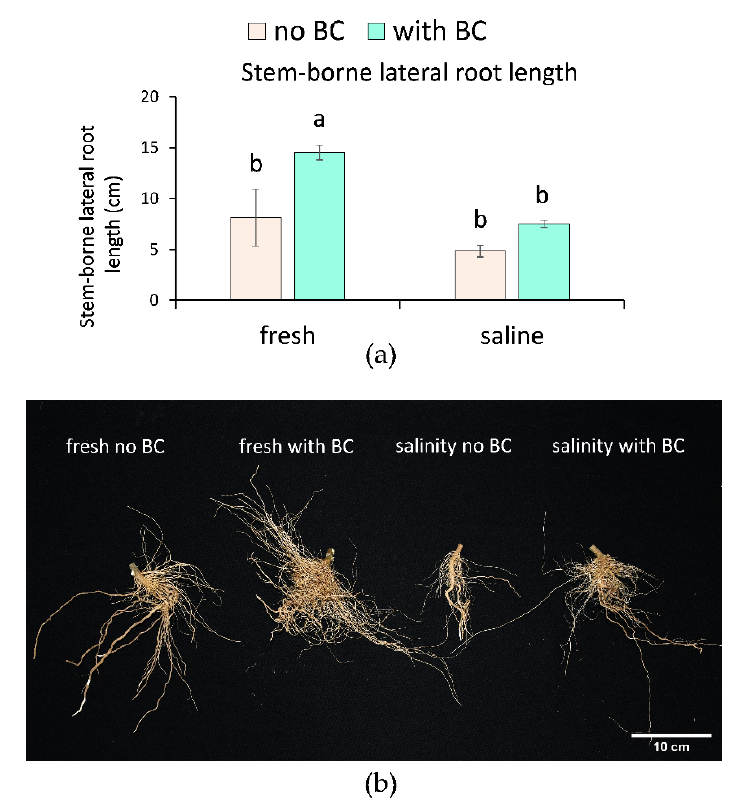
Figure 4. Effect of biochar addition on stem-borne lateral root length under fresh and saline irrigation regime: ( a ) stem-borne lateral root length. Values represented the means of five biological replications (three plants each) ± SE (n = 120, two seasons). Means with the same letters are not significantly different according to Duncan’s multiple range test (DMRT) ( p ≤ 0.05). ( b ) a representative image of the topsoil 10 cm of the stem-borne lateral root extracted from top soil, scale bar equals 10 cm.